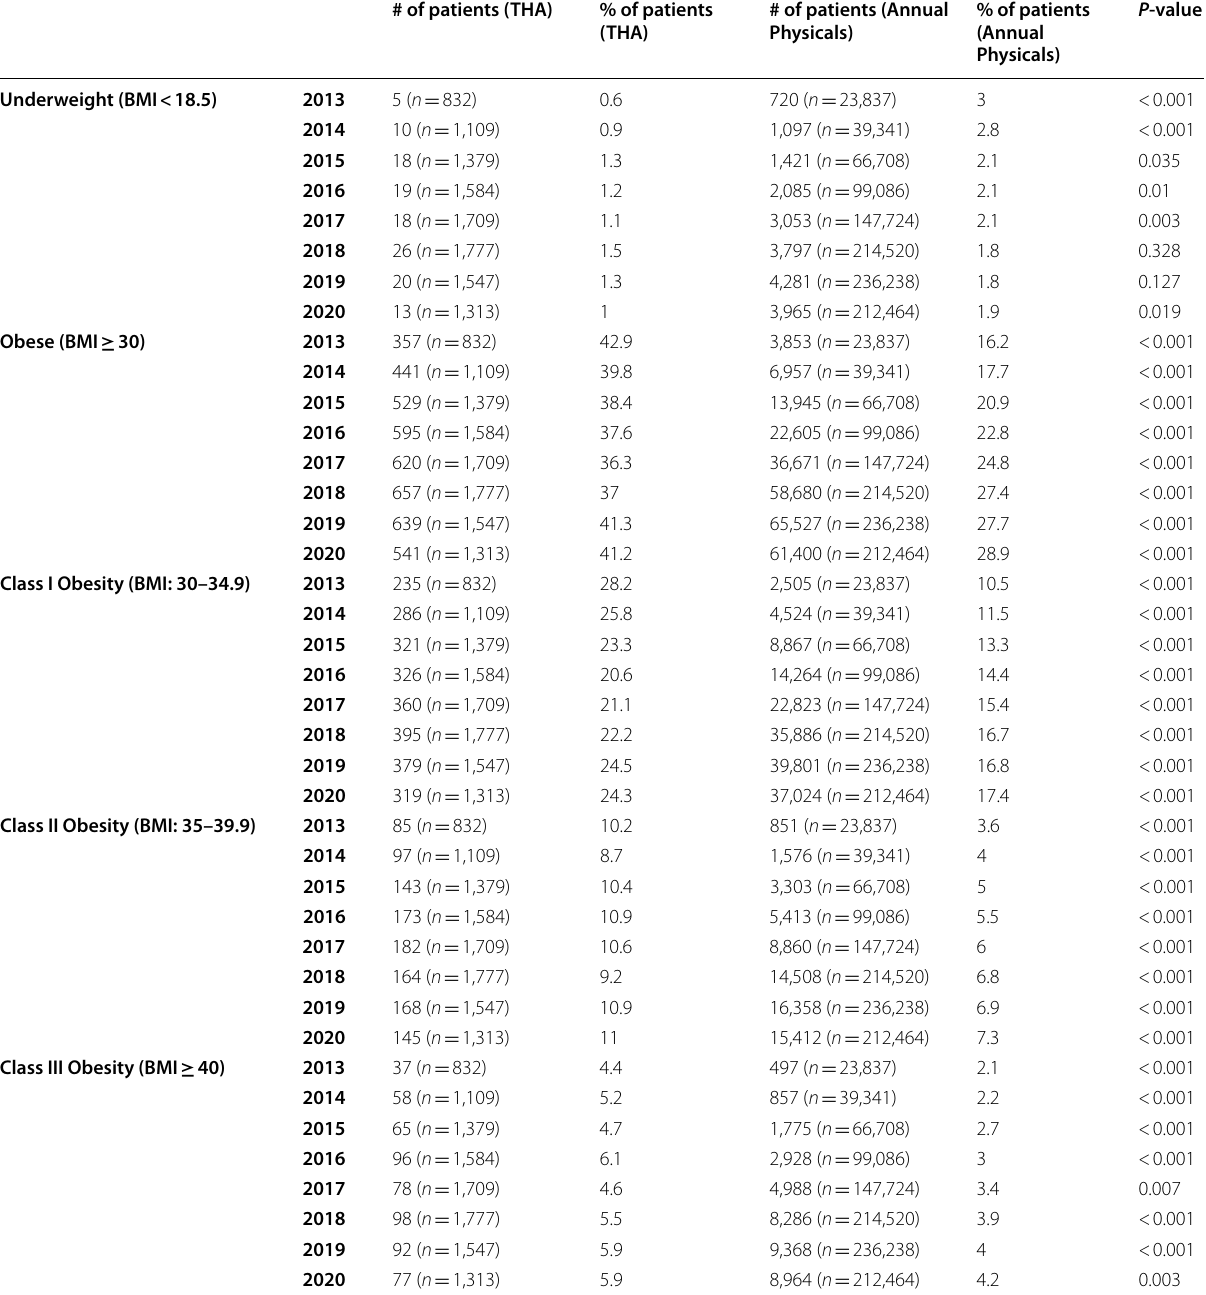
# of patients (THA) % of patients